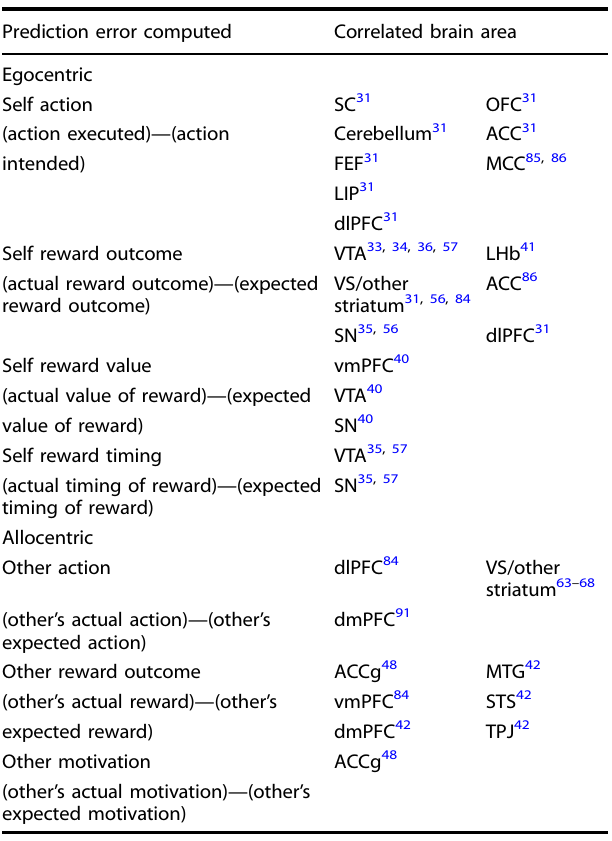
Table 1. Representative list of brain areas in which signals that can be described as prediction errors have been found from either primate electrophysiology or human neuroimaging